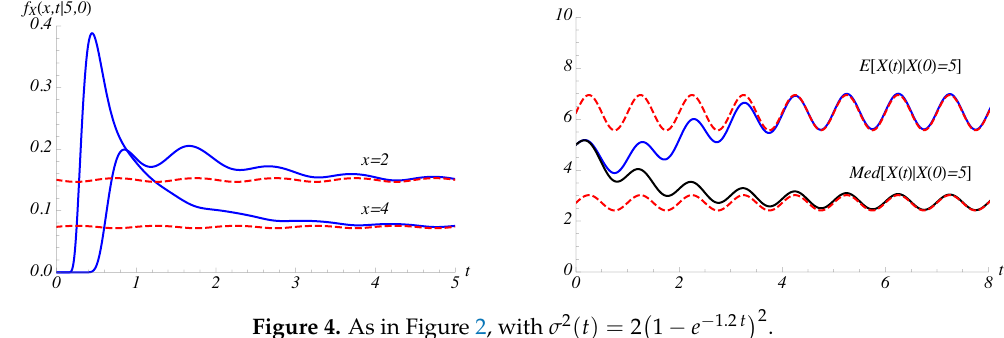
Figure 4. As in Figure 2, with σ 2 ( t ) = 2